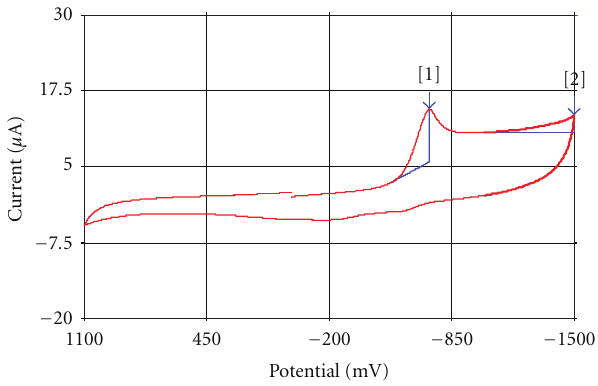
Figure 4: Cyclic voltammogram of complex of V 2 with Ca(Pic) 2 . Scan rate 100(mV/s) and switching potential from 1100mV to − 1500mV.